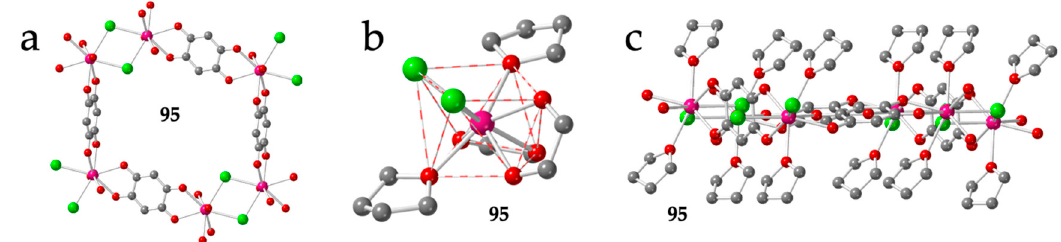
Figure 12. ( a ) View of a distorted hexagonal ring in compound 95 showing the two short sides corresponding to the double Cl ‐ bridges (only the O atom of the thf molecules is shown for clarity). ( b ) View of the coordination environment of the Gd(III) ion in compounds 95 . ( c ) Side view of the hexagonal ring in 95 . Colour code: Ln = pink, C = grey, O = red and Cl = green.